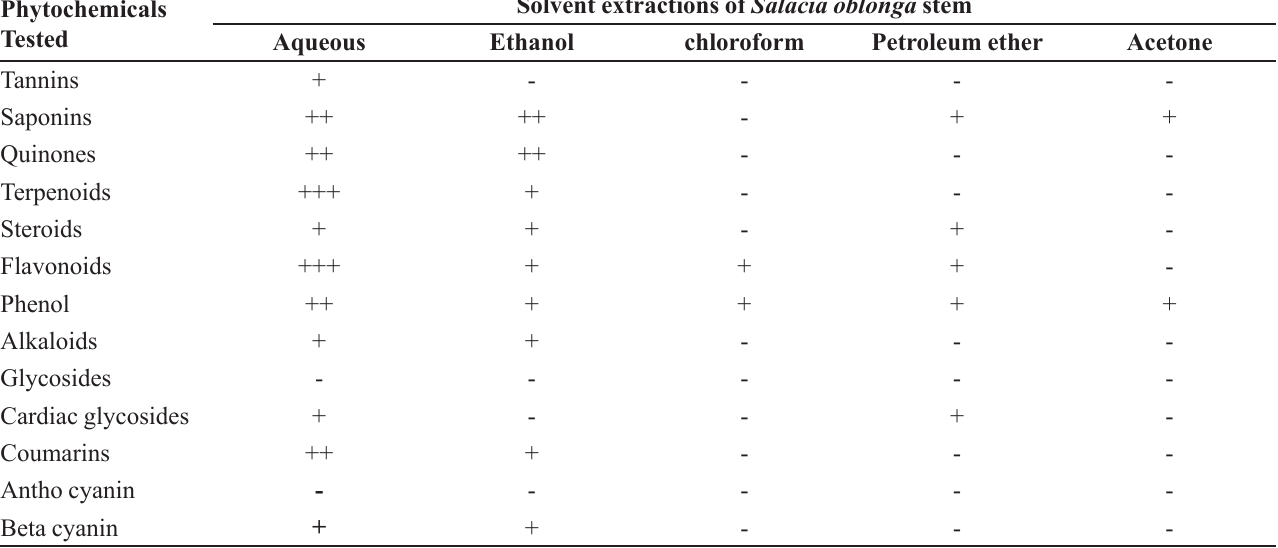
TABLE I - Qualitative phytochemical analysis of stem extracts of S. oblonga